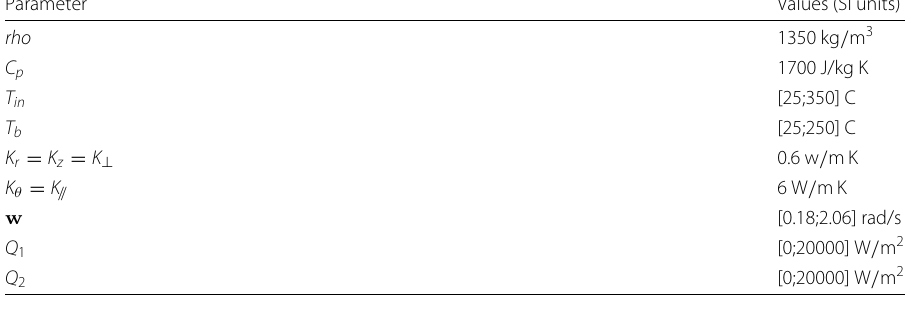
Table 2 Process and material parameters